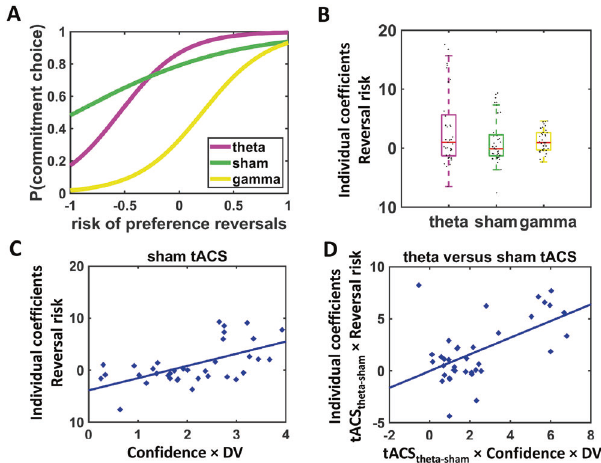
Fig. 3 Stimulation effects on precommitment (based on the results of the mixed generalized linear model for the precommitment task) and relation to individual differences in impulsiveness. A Theta tACS enhanced the willingness to precommit with increasing risk of preference reversals in the precommitment task. B Individual regression coef fi cients for the impact of Reversal risk, separately for each tACS condition. Higher coef fi cients indicate a stronger willingness to precommit with an increasing risk of preference reversals. Colored boxes indicate median and interquartile range, whiskers are de fi ned as 1.5 times the interquartile range or up to the most extreme observed data point falling within this range. Black dots indicate individual data points ( N = 37 participants). C , D Relationship between metacognitive sensitivity (Difference in value (DV) × Con fi dence) and sensitivity to precommitment demand (Reversal risk). C In line with theoretical models, agents with higher metacognitive sensitivity showed the strongest sensitivity to precommitment demands under sham. D Improved metacognitive sensitivity under theta relative to sham tACS predicts stronger effects of frontopolar theta tACS on the sensitivity to the risk of preference reversals.